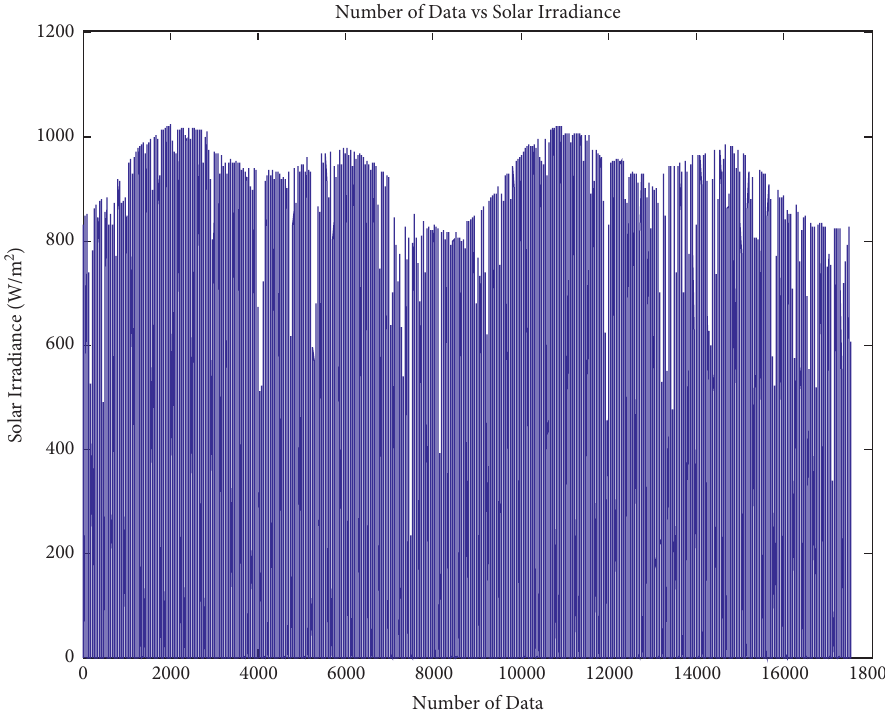
Figure 6: Number of data vs. solar irradiance.